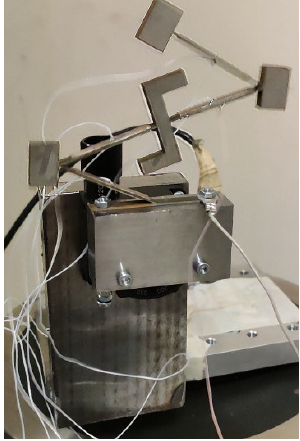
Figure 12. Prototype of the energy harvester.